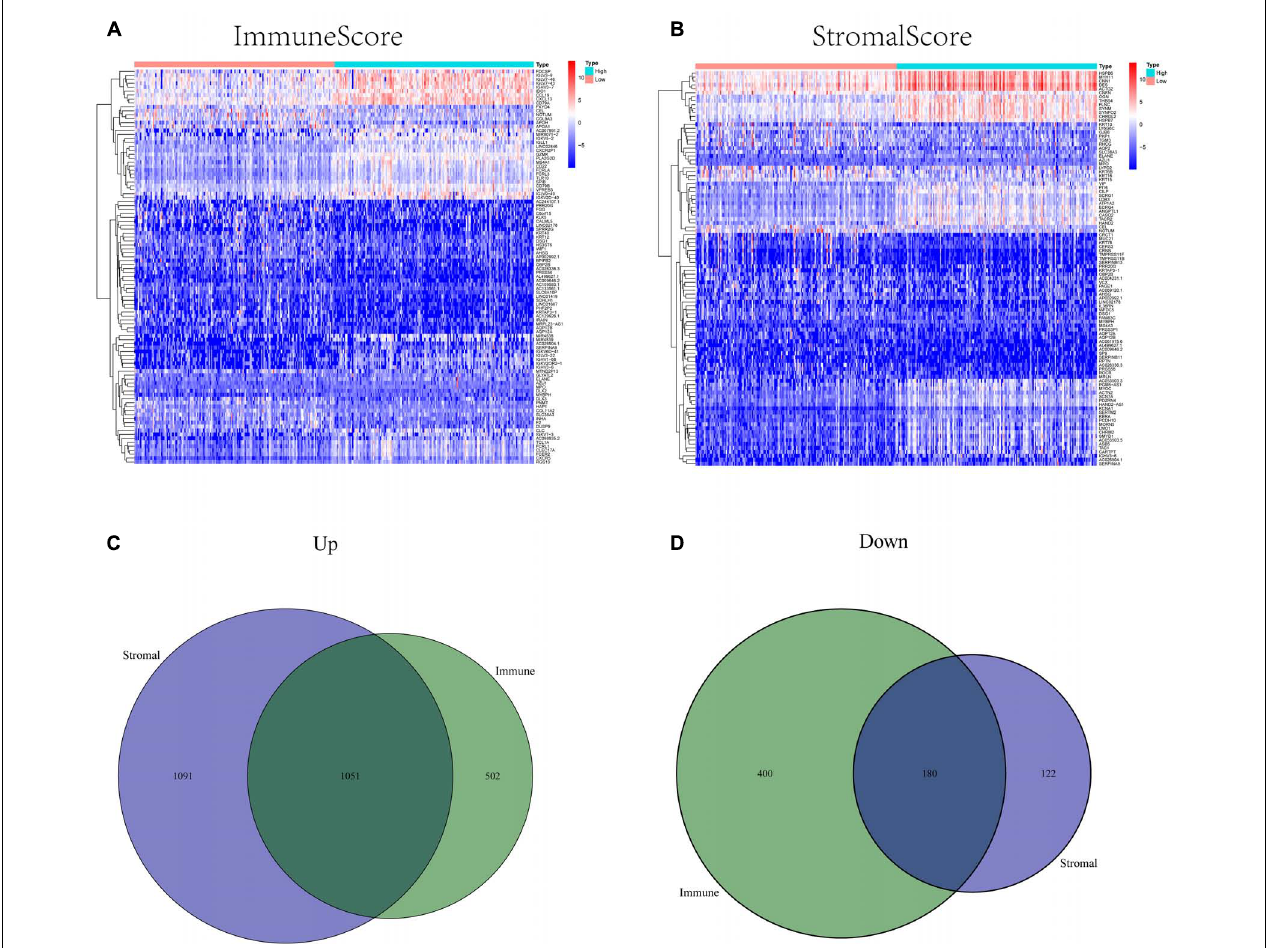
FIGURE 1 | Heatmaps and Venn plots of differentially expressed genes (DEGs). (A) A heatmap of immune-related DEGs between the high- and low CXCR4 expression groups. (B) A heatmap of stromal-related DEGs between the high- and low CXCR4 expression groups. (C) A Venn diagram of commonly upregulated DEGs in the stromal and immune components. (D) A Venn diagram of commonly downregulated DEGs in the stromal and immune components.